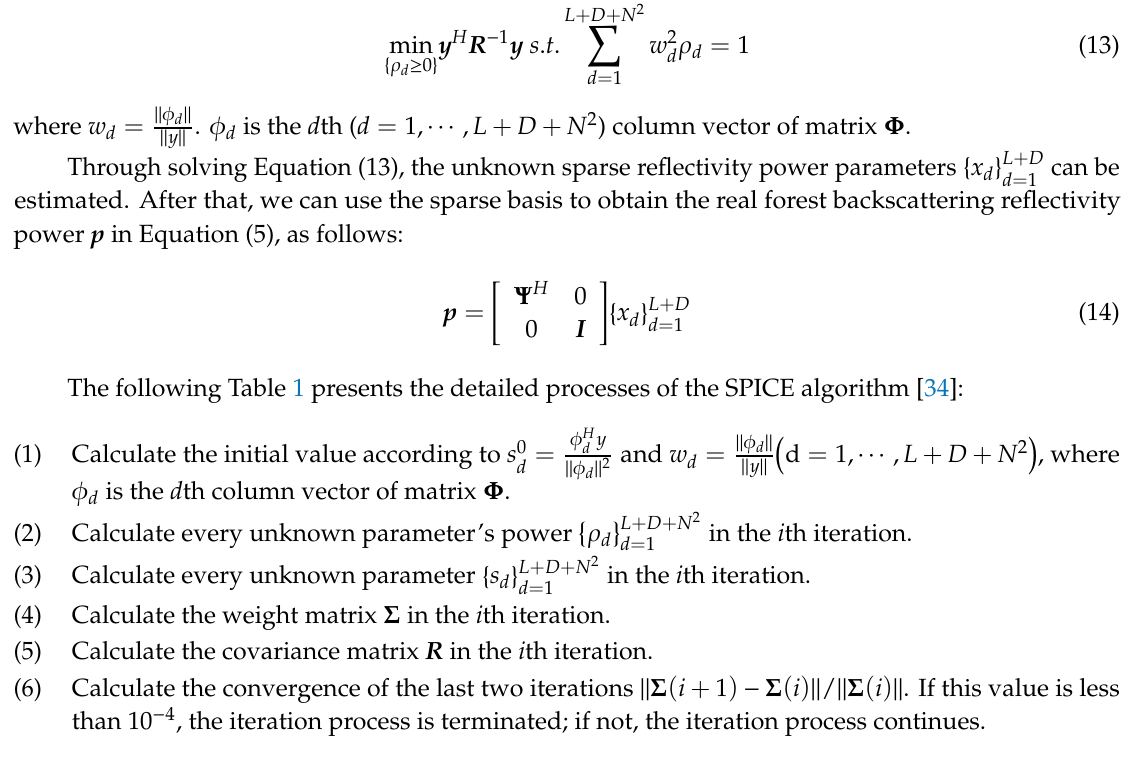
Table 1. Pseudocode of the W&O-SPICE algorithm.